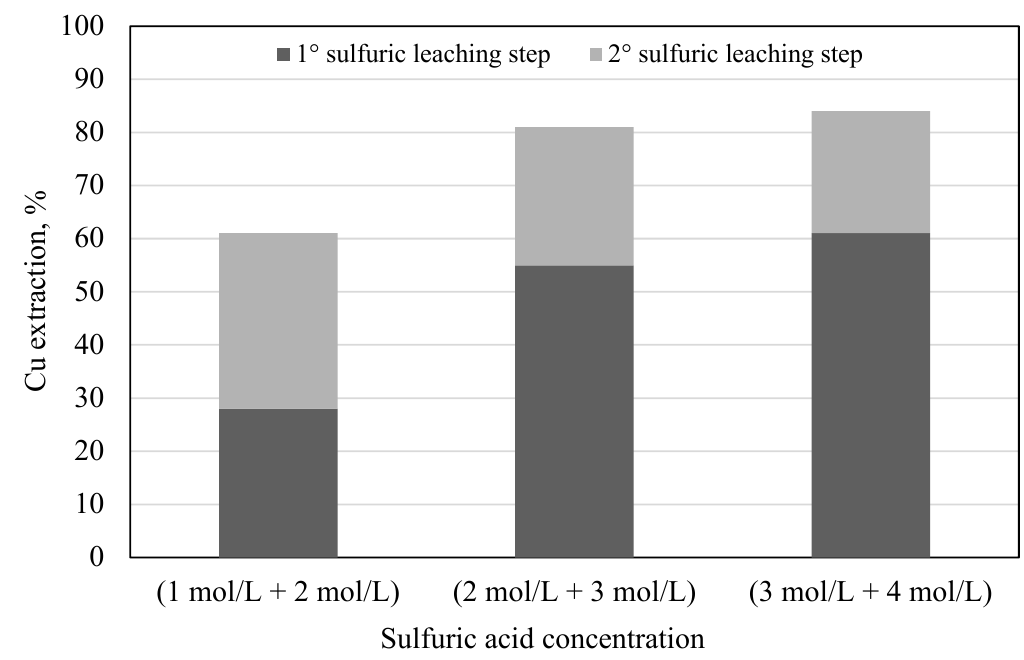
Figure 3. Copper dissolution yields as a function of sulfuric acid concentration in the two-step leaching. H 2 O 2 20% v/v, L/S ratio 10, T 25 °C, leach time 1 h, particle size −0.5 mm, and stirring 250 rpm.